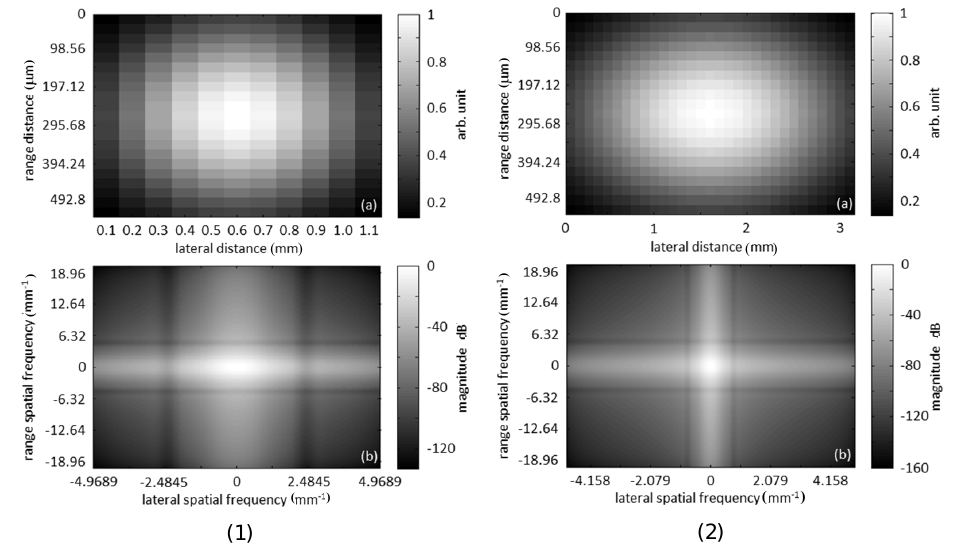
Figure 8. 2D Gaussian spatial windows used for discrete Fourier transform ( a ) and their power spectra ( b ). Lateral and axial window sizes are ( ± 0.5 mm ( M = 5), ± 0.2464 mm ( K = 10)) ( 1 ) and ( ± 1.5 mm ( M = 15), ± 0.2464 mm ( K = 10)) ( 2 ).